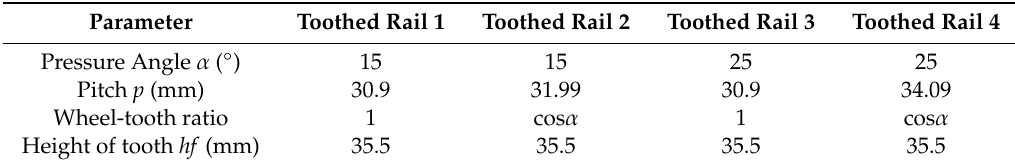
Figure 8. Toothed rails for the testing. Table 1. Rack parameters of each toothed rail.